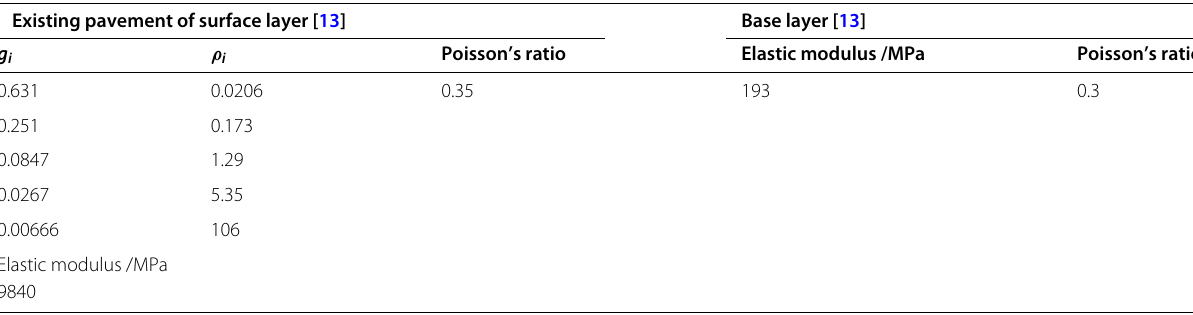
Table 1 Existing pavement Prony series parameters Existing pavement of surface layer [13]